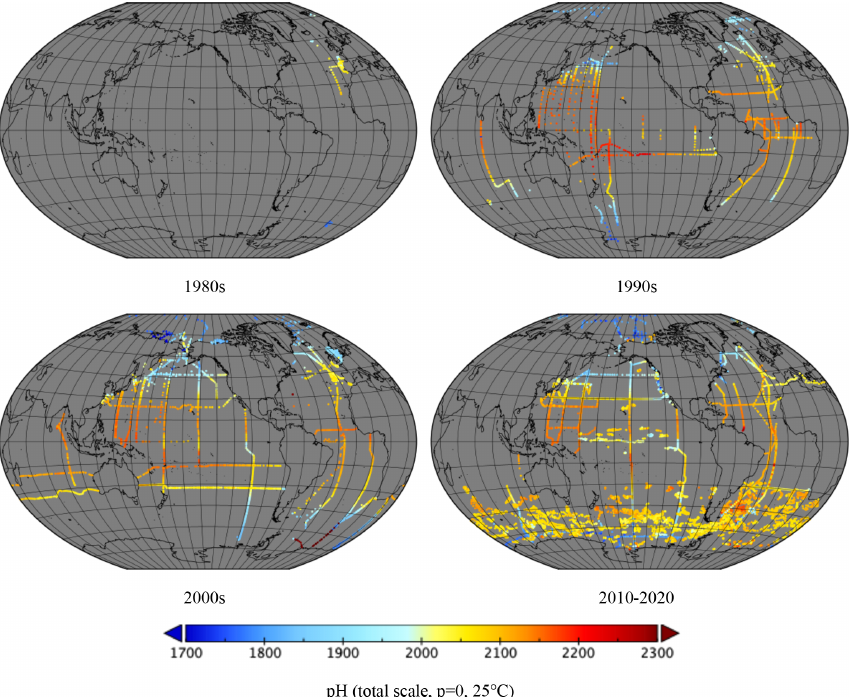
Figure 14. Mean pH (total scale, p = 0, 25 ◦ C) divided into decades: 120 ROIs in the 1970s, 672 in the 1980s, 3428 in the 1990s, 4632 in the 2000s and 10761 from 2010 to 2020.